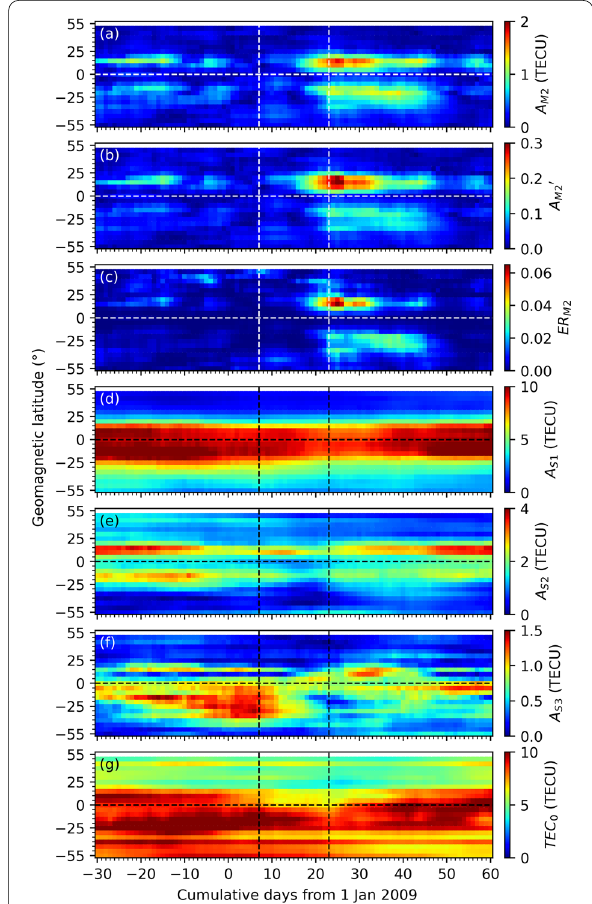
Fig. 4 The variations of A M2 , A M2’ , ER M2 , A S1 , A S2 , A S3 , and TEC 0 (a to g) calculated with Eq. (1) from TEC data in Fig. 3. The vertical dashed lines are the same as those in Fig. 2a. The horizontal dashed lines represent the geomagnetic